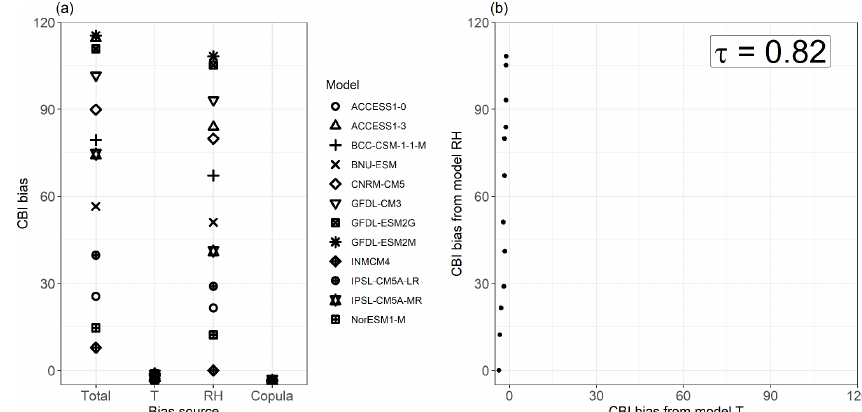
Figure 6. Spread of mean total bias in the 95th quantile (Q95) of CBI and its contribution from T , RH, and their copula for individual CMIP5 models (a) , and a scatter plot of the T and RH contributions to Q95 CBI bias, with their Kendall rank correlation coefficient ( p value < 0.001) (b) . Shown are the results for a grid point in Brazil (Amazonia, 5 ◦ S and 56.5 ◦ W). Bias was calculated as (CMIP5 or transformation minus ERA-Interim). Equal axes are used in panel (b) to highlight the differences in spread between both bias